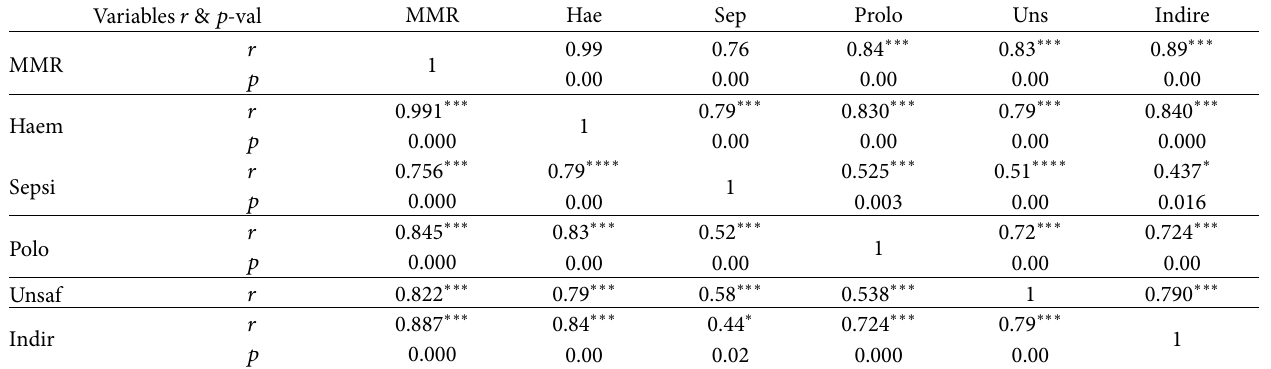
Table 2: Correlation between all the causes and MMR (excluding hypertension as independent variable).